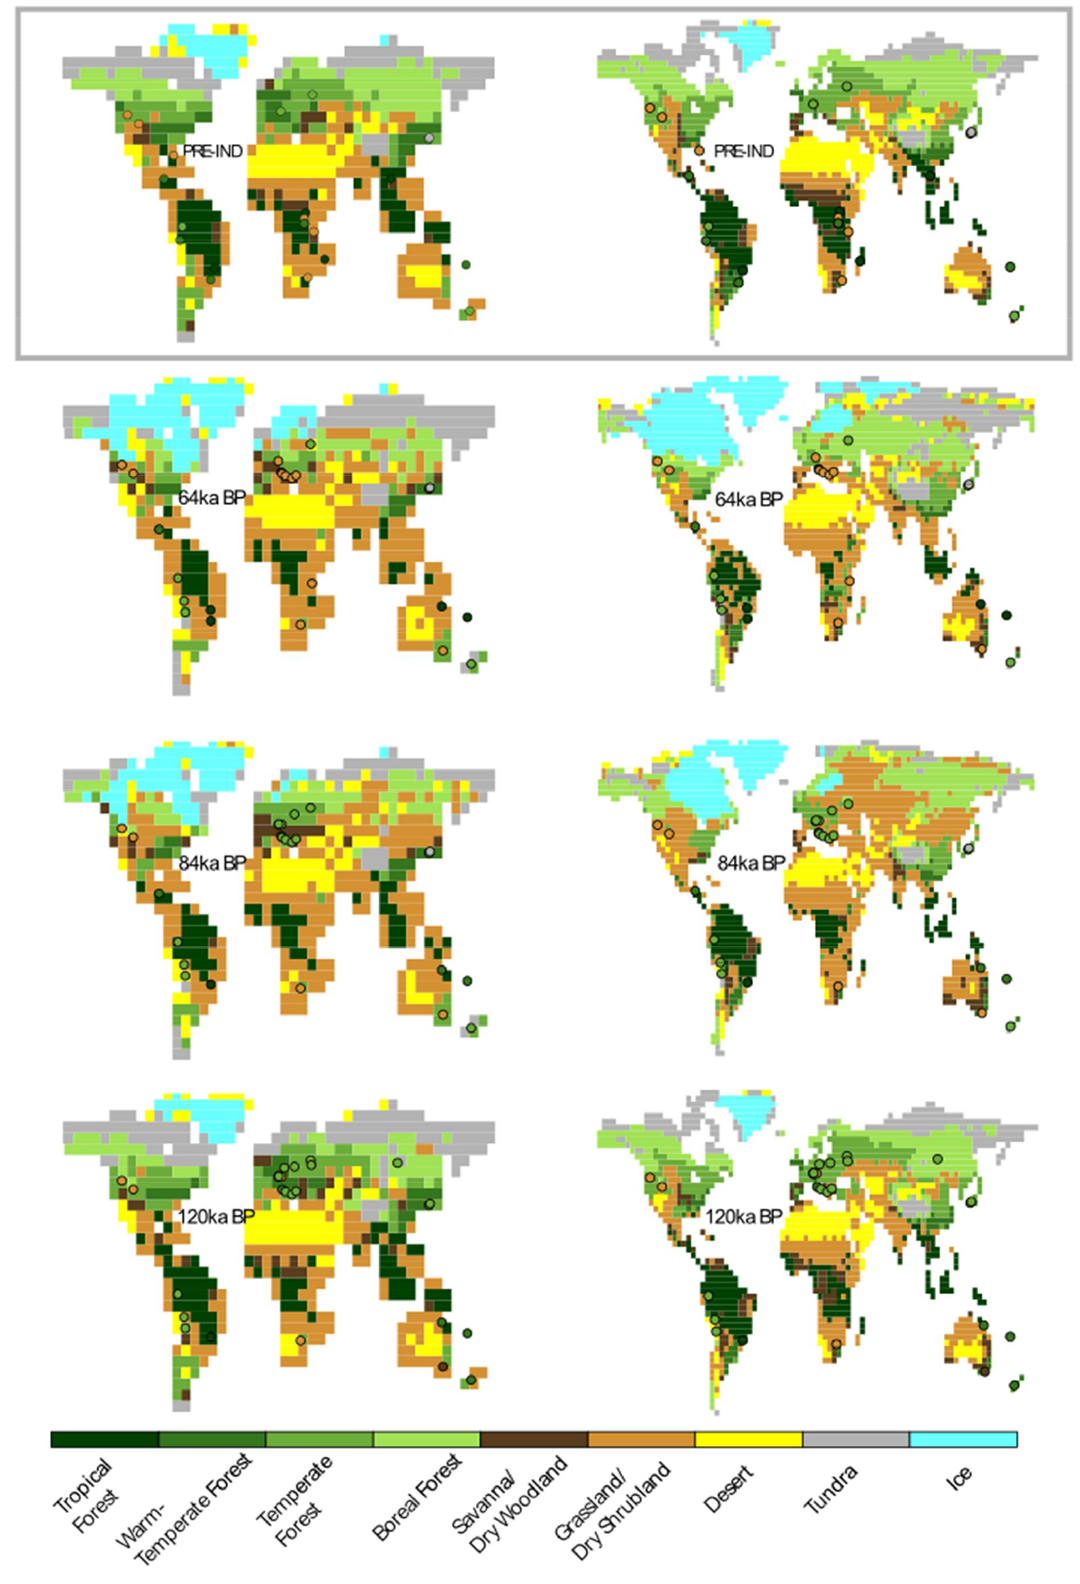
Figure 2. Reconstructed biomes (defined through highest affinity score) superimposed on simulated biomes using FAMOUS (B4F, left) and HadCM3 (B4H, right) climates for selected marine isotope stages (denoted in ka